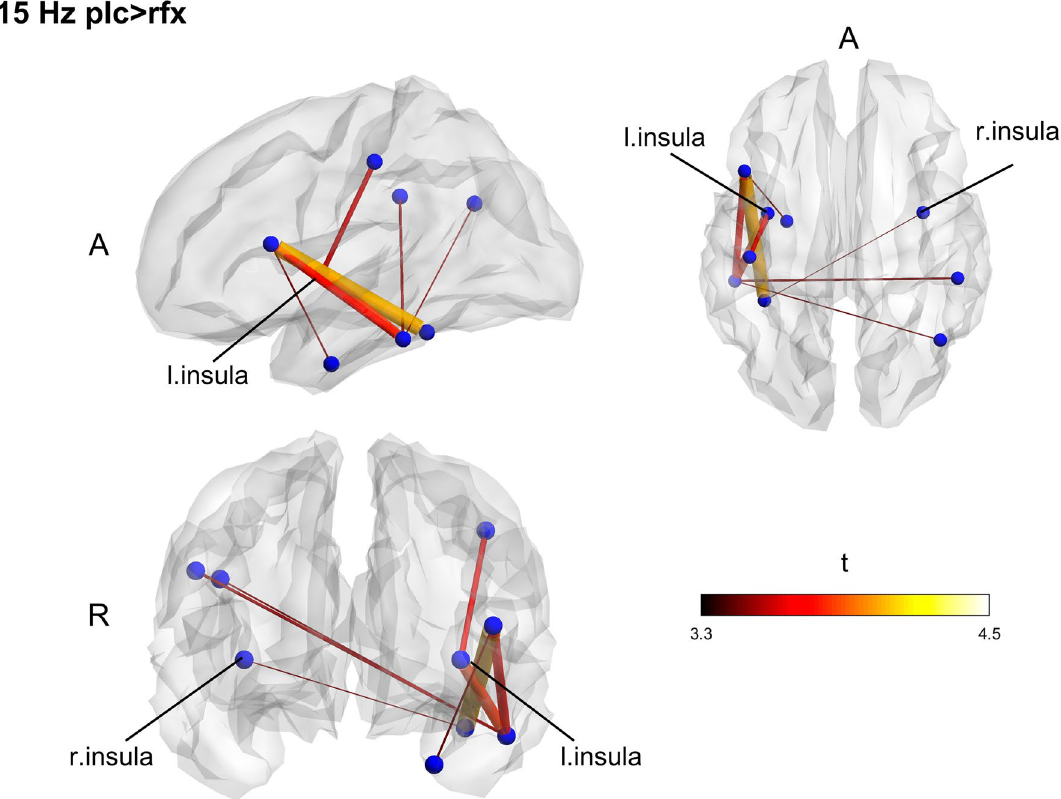
Figure 1. Between groups functional connectivity comparison in post-treatment session. The placebo group displays two networks with increased connectivity in slow and fast beta band (15 Hz) compared to the Rifaximin group. Clusters of higher connectivity are located mainly in the left hemisphere, involving frontal, temporal, and parietal areas. To note the presence of the insular cortex within the networks. Color and size of the edges are proportional to t-statistic (t) value ( A anterior, R